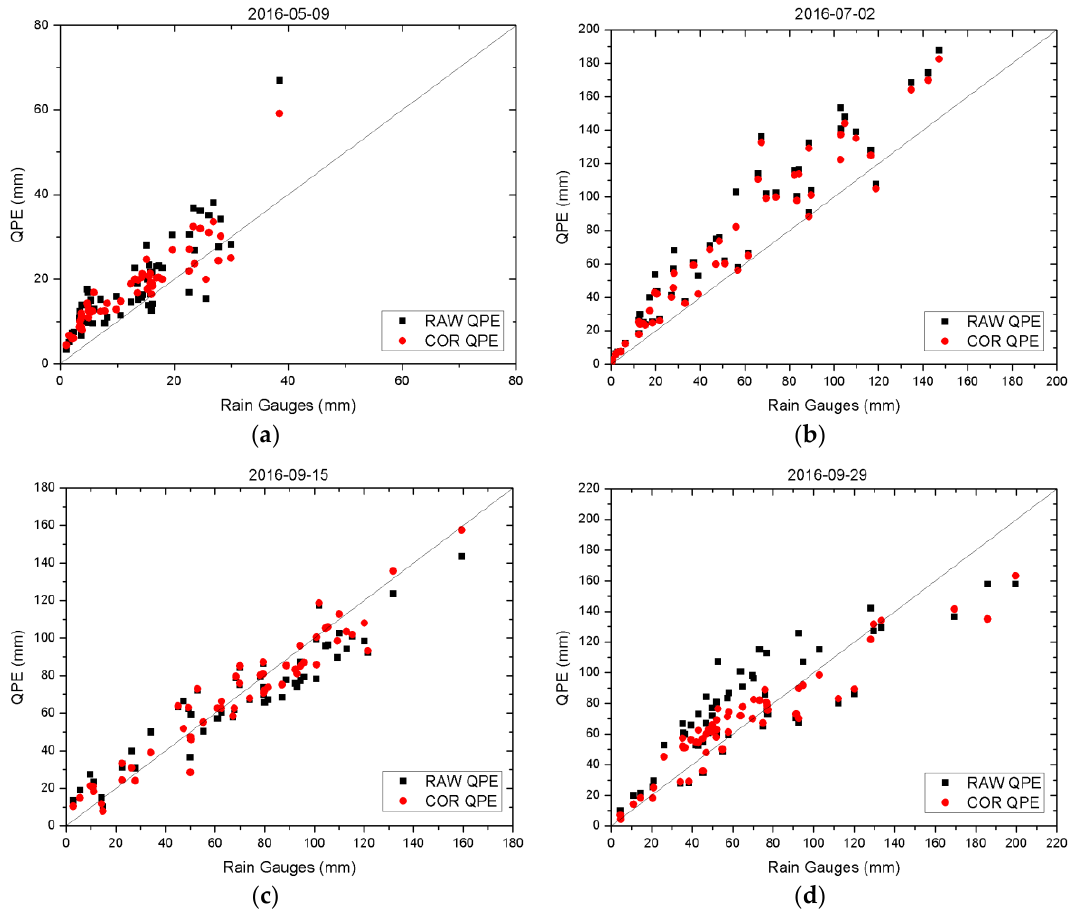
Figure 11. Raw and corrected MGR-QPE versus measured rainfall of rain gauges. ( a )–( d ) indicate 05-09, 07-02, 09-15 and 09-29 precipitation events, respectively.